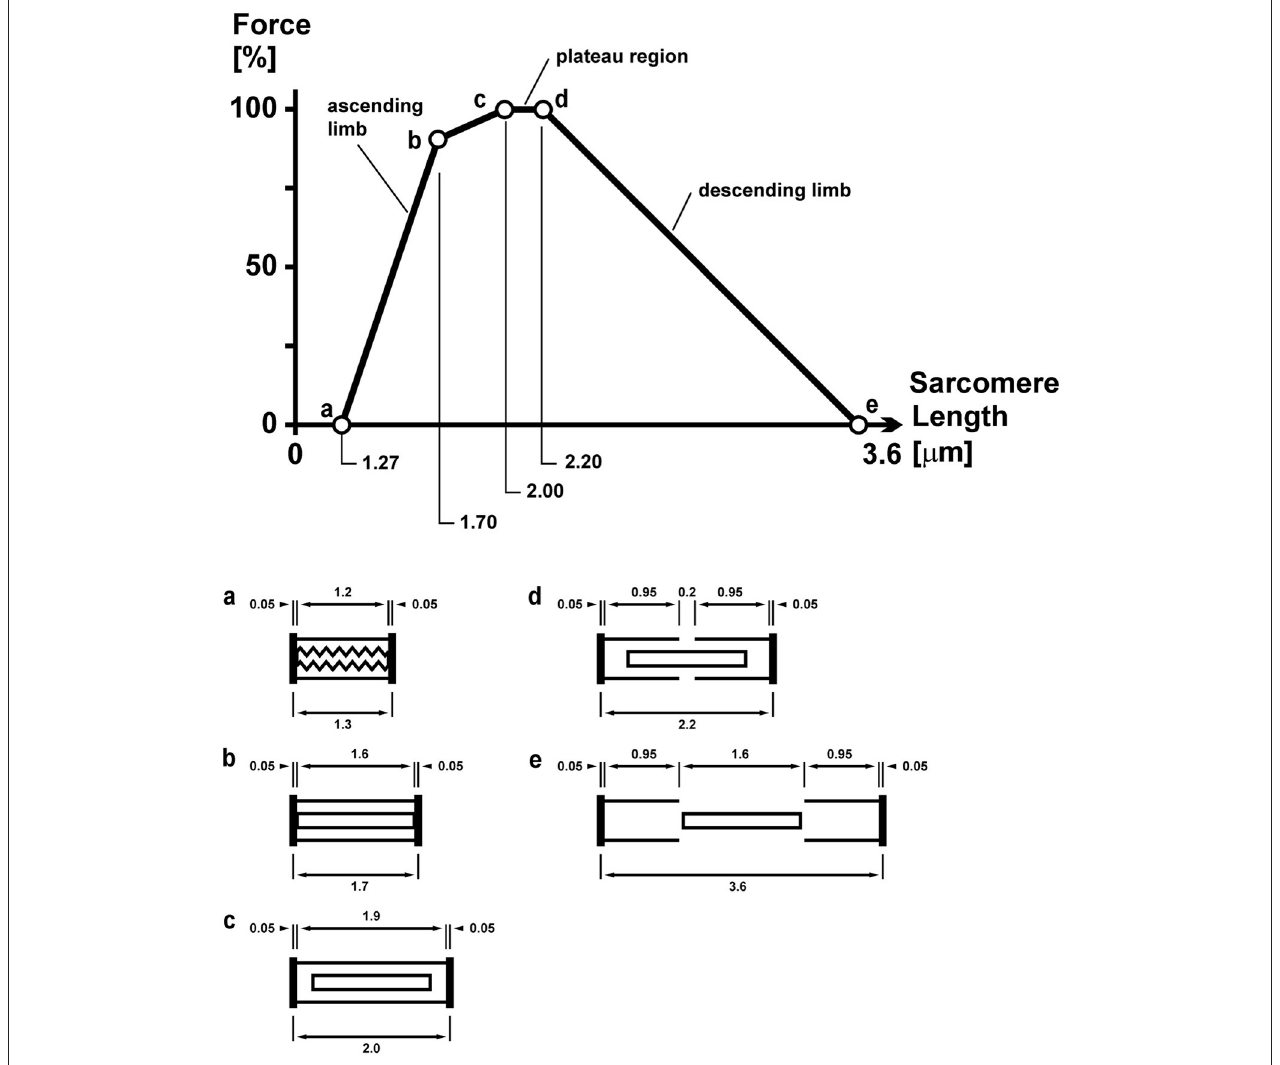
FIGURE 10 | Sarcomere force–length relationship of a frog skeletal muscle as first described by Gordon et al. (38). The so-called plateau and descending limb regions are well explained by the sarcomere lengths (shown schematically below for lengths c, d, and e) and the corresponding overlap between the contractile filaments actin and myosin. The overlap between these filaments determines the number of possible cross-bridge interactions and thus the maximal, isometric force